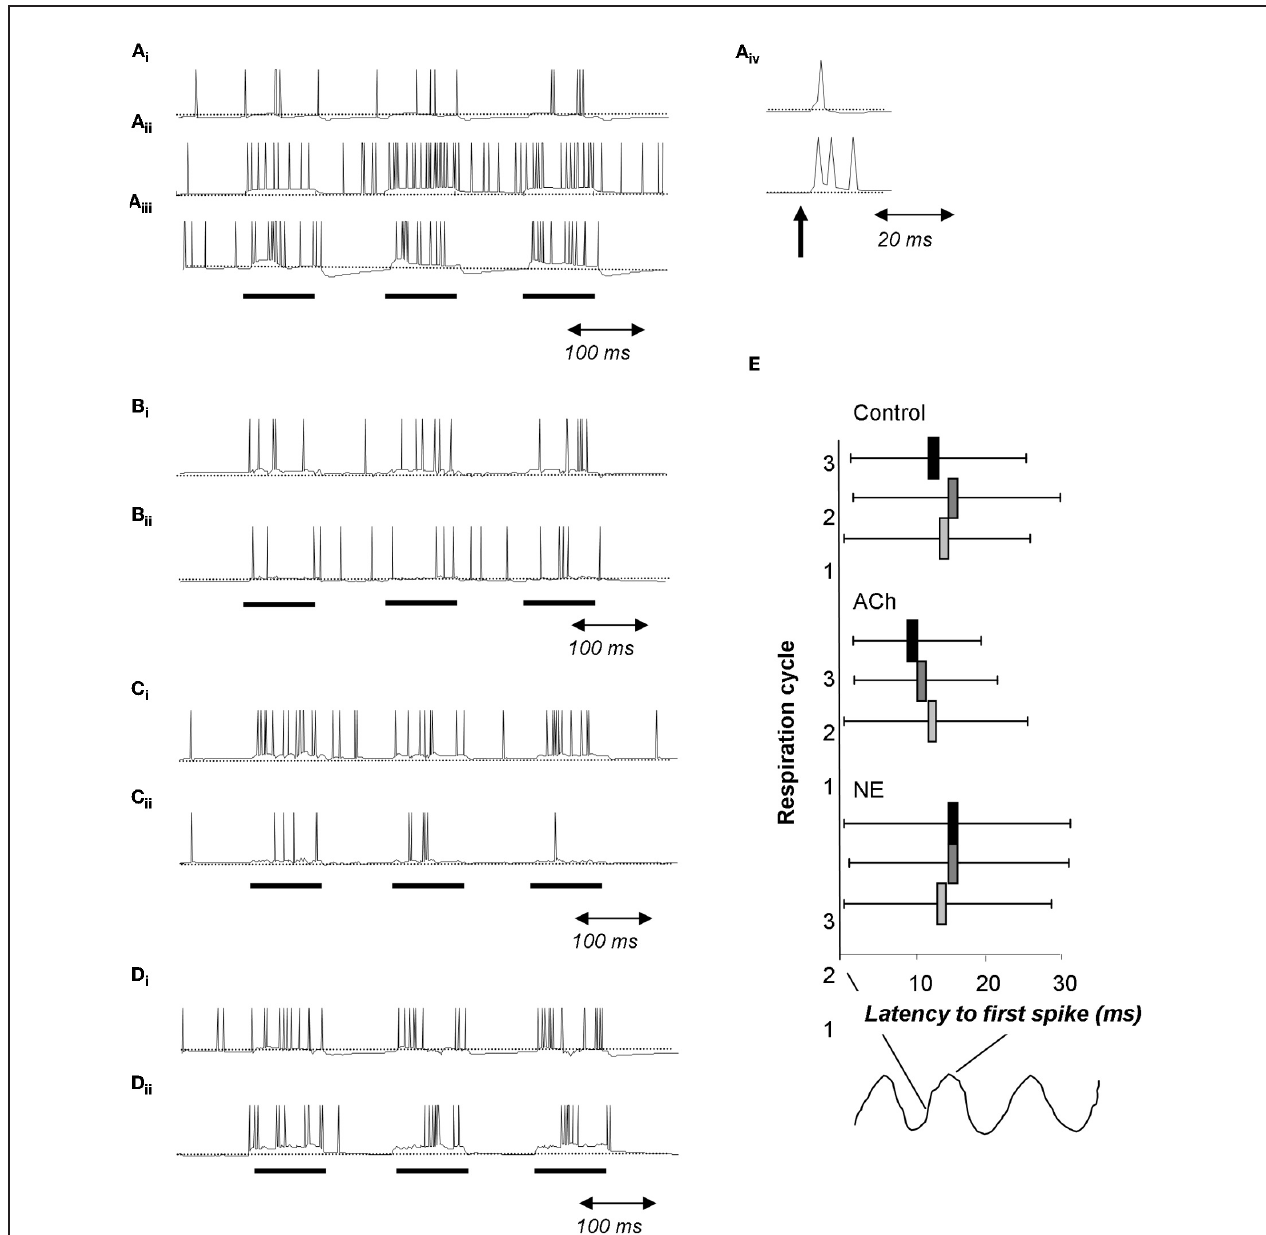
FIGURE 7 | Cholinergic and noradrenergic modulation of granule cells. (A) Simplified integrate and fire model of a granule cell. (A i ) Baseline condition. The cell is driven with 100ms pulses of current injection separated by 100ms. (A ii ) Activation of muscarinic receptors changes afterhyperpolarization into afterdepolarization; as a consequence the cell is more active during the interstimulus intervals. (A iii ) Activation of α 1 NE receptors depolarizes the cell leading to an increase in the evoked response followed by a strong hyperpolarization during the interstimulus intervals. (A iv ) When driven by a short current pulse (1ms), the baseline granule cells emits a single spike followed by a small after hyperpolzarization (upper trace) whereas the granule cell under muscarinic activation responds with a spike followed by a afterdepolarization capable of triggering additional spikes. (B) In this simulation, a single mitral cell (B ii ) receives 100ms current injections, drives an attached granule cell and is inhibited by this same granule cell (B i ) . (C) In this simulation the granule